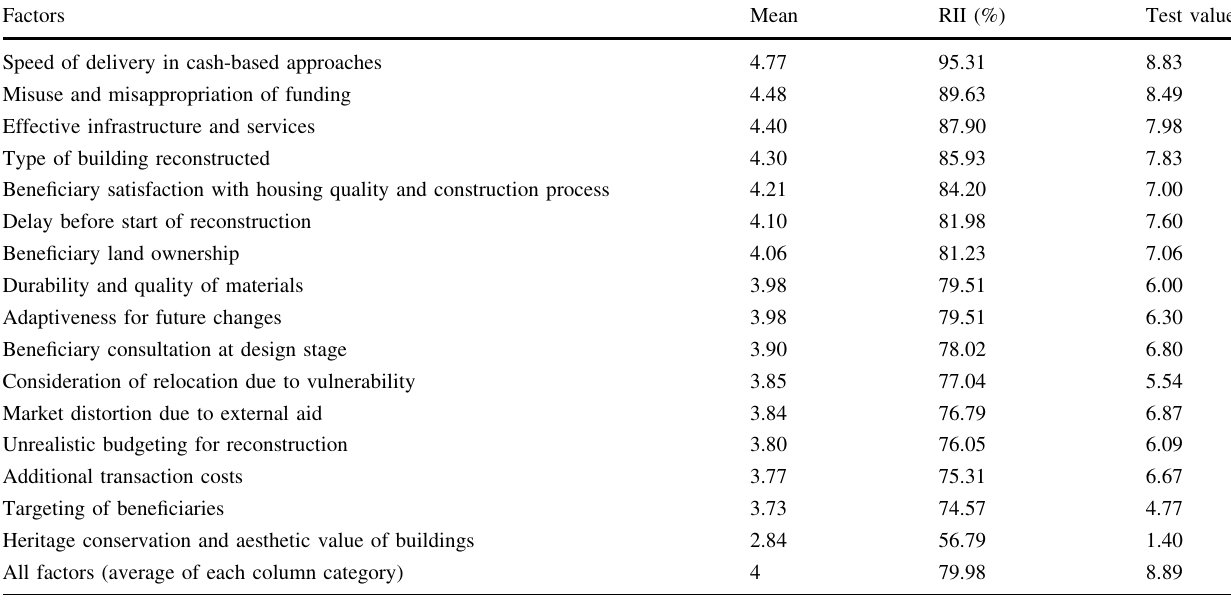
Table 2 Factors influencing housing approaches in the Gaza Strip Factors